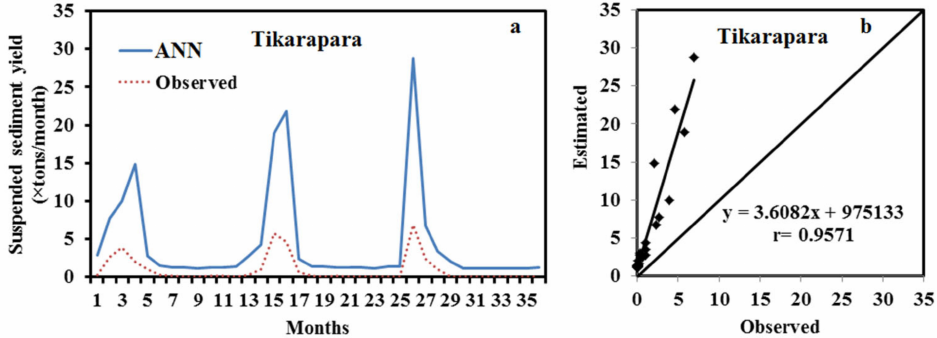
Figure 9. ( a ) Hydrograph between the predicted and actual SSY at Tikarapara using the ANN-1 model; ( b ) Scatter plot between the predicted SSY and actual at Tikarapara using the ANN